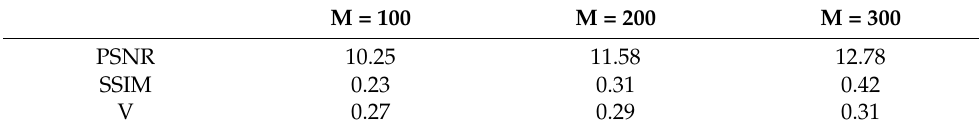
Table 3. The respective PSNR and SSIM for different measurements (object “+”).